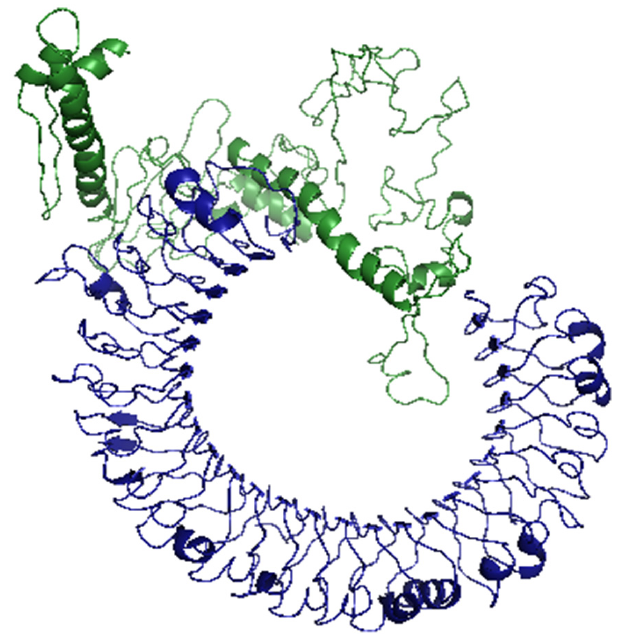
Figure 6. Docked complex of the designed vaccine (green color) and TLR3 (blue color).